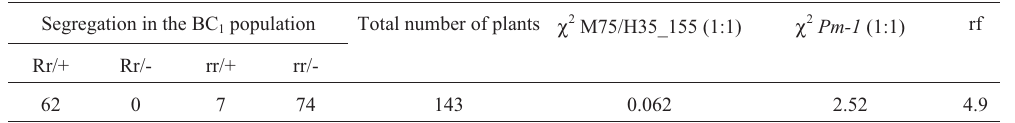
Table 1 - Number of resistant (Rr) and susceptible (rr) backcross (BC 1 F 1 ) Cucumis melo plants showing the presence (+) or absence (-) of the amplified fragment length polymorphism (AFLP) marker M75/H35_155. Chi-squared ( χ 2 ) and recombination frequency (rf) values are also